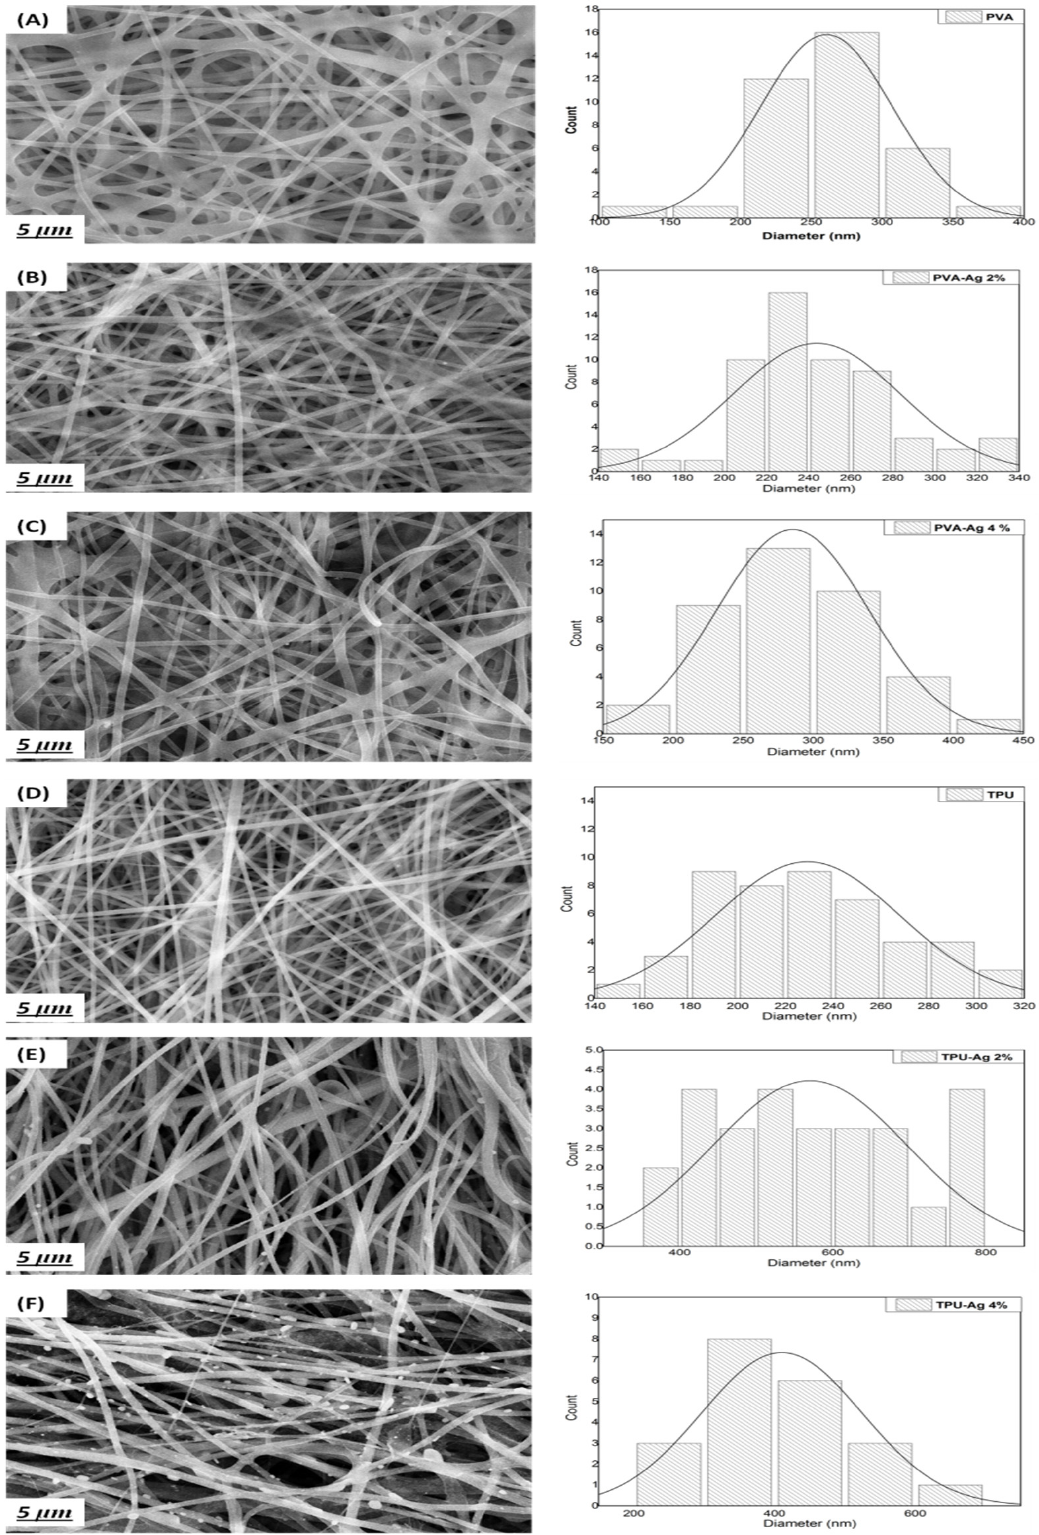
Figure 1. SEM images and fiber diameter distribution of PVA control ( A ), PVA-Ag 2% ( B ), PVA-Ag 4% ( C ), TPU control ( D ), TPU-Ag 2% ( E ), and TPU-Ag 4% ( F ).